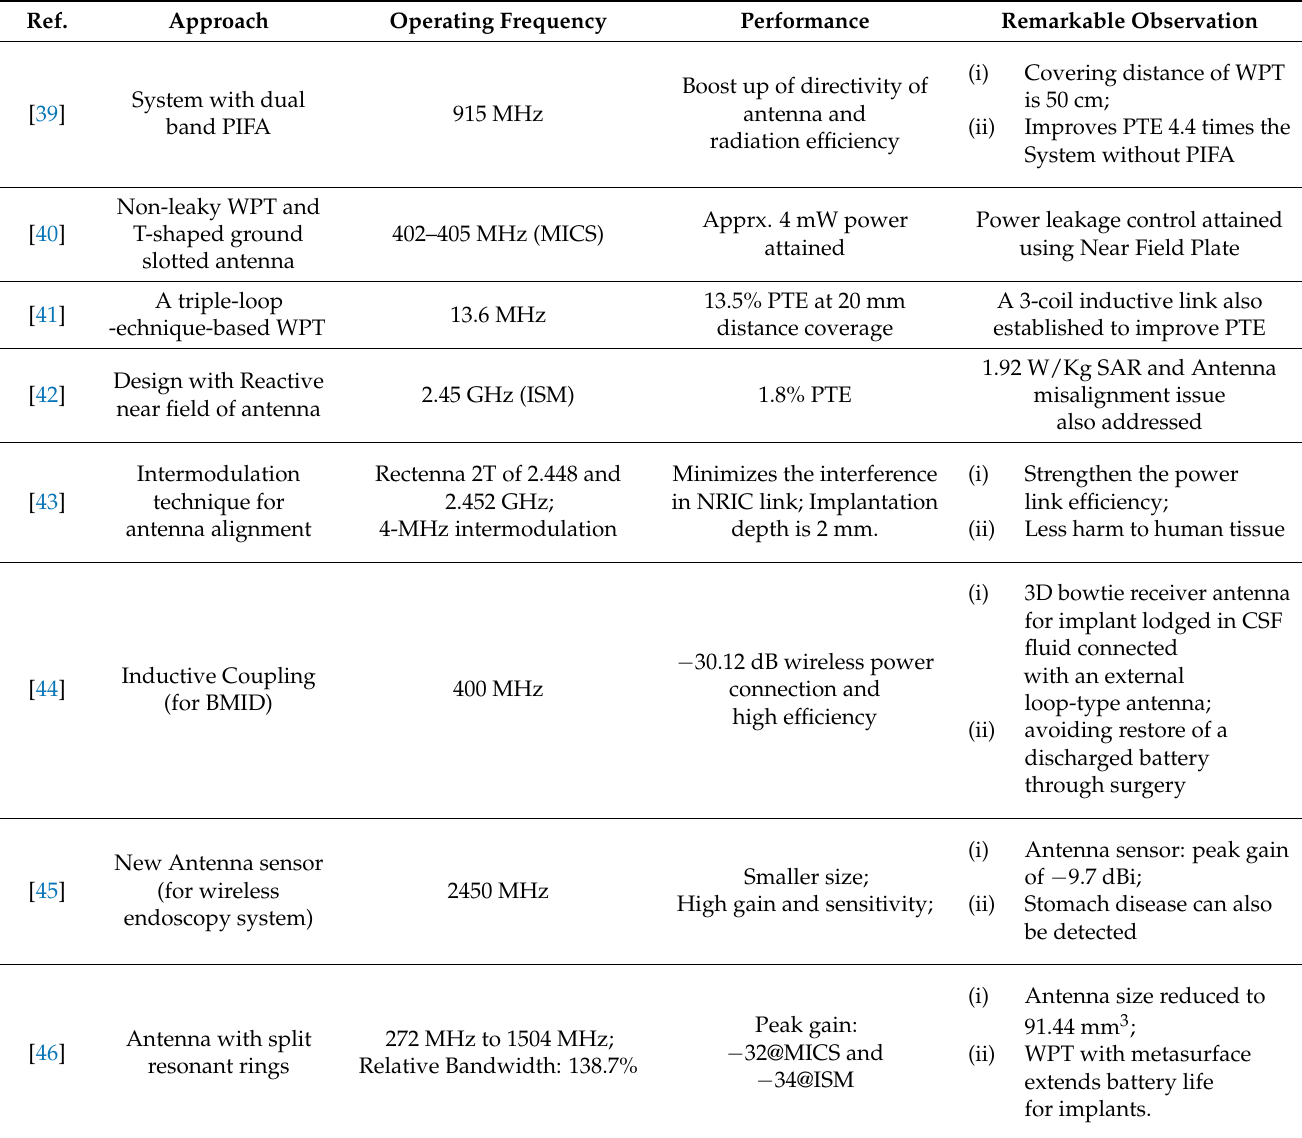
Table 4. WPT systems based on antenna